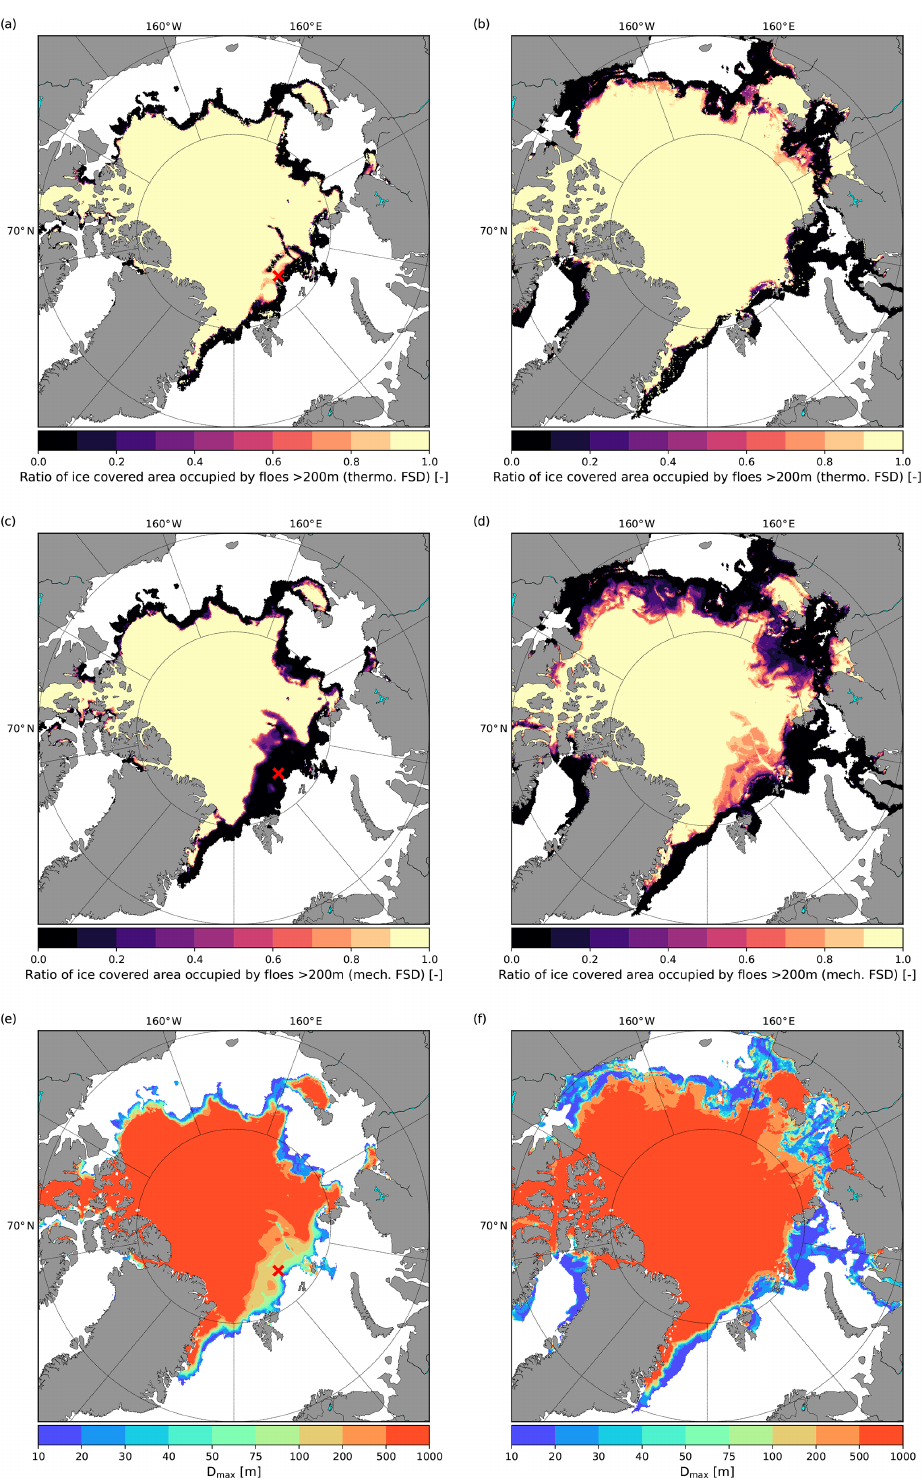
Figure 5. Pan-Arctic distribution of the area covered by floes with diameters larger than 200m over the total sea ice cover area according to the fast-growth (a, b) FSD, slow-growth FSD (c, d) , and distribution of the maximum floe size (e, f) . Each column corresponds to a different time: 2 October 2015 00:00:00 (a, c, e) and 1 November 2015 00:00:00 (b, d, f) . The red cross (a, c, e) indicates the location at which the FSDs shown in Fig. 6 and the floe size parameters in Fig. 7 are